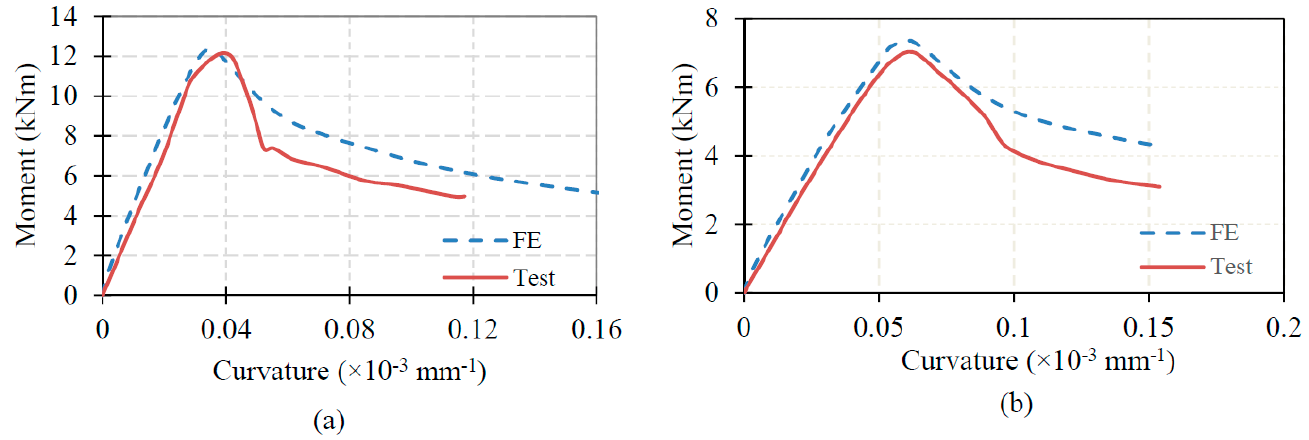
Figure 10. Failure curve comparison for ( a ) OT1.2-136-S150 ( b ) OT1.2-86-S300 [13].